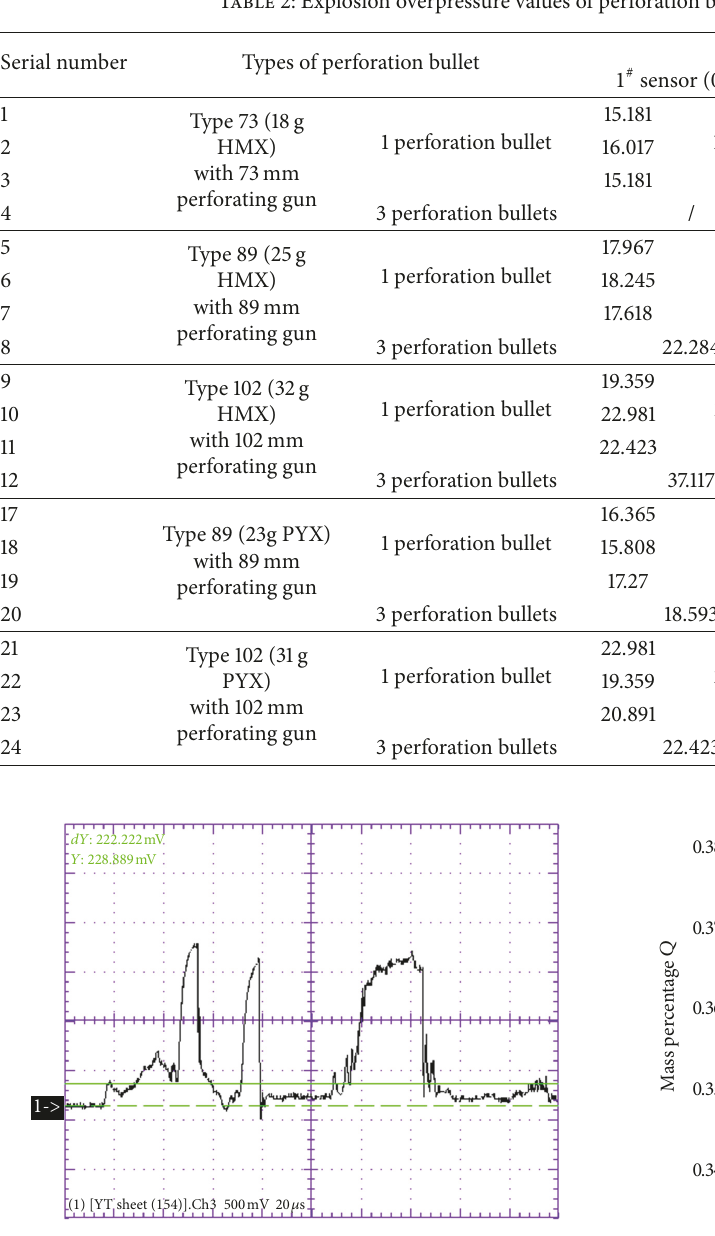
Figure 11: Typical pressure signals collected in the test.